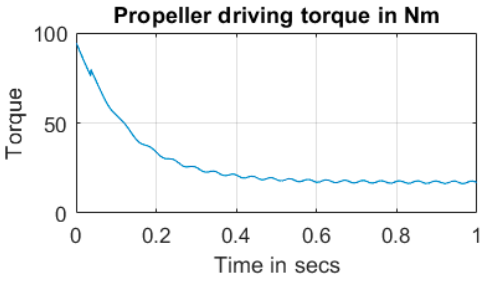
Figure 5. Variation of the HTS PMSM load torque as a function of time over the timeframe of 1 s at the superconducting temperature.